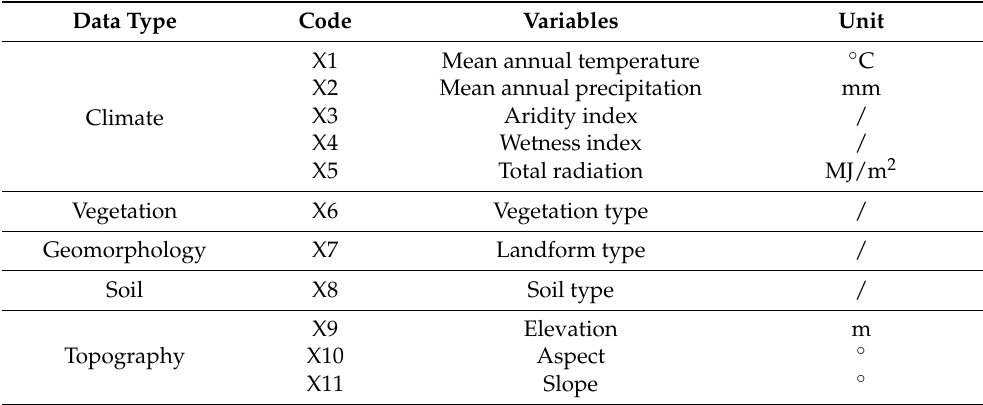
Table 1. Environmental data indicators and their